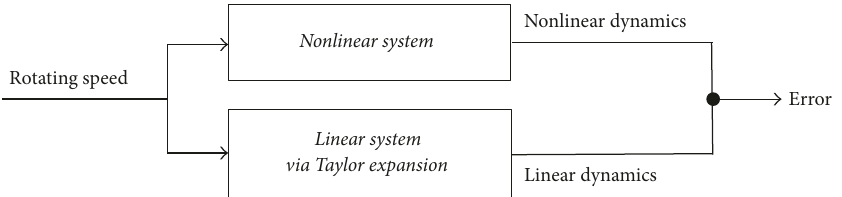
Figure 2: Setup for nonlinearity measure for dynamics of rotor